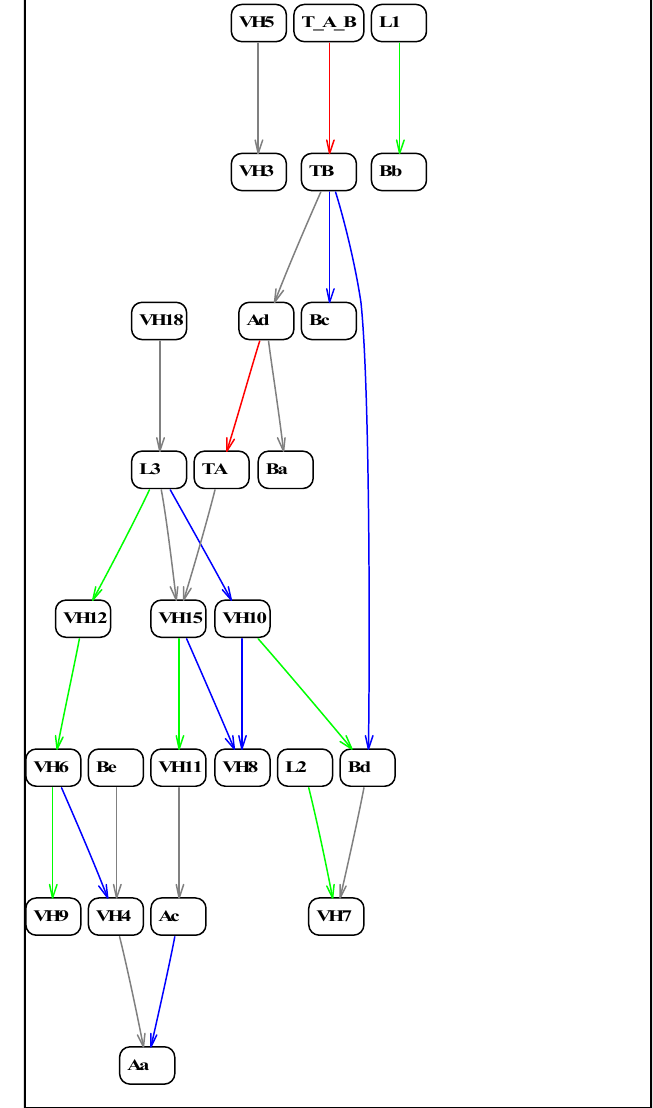
Figure 9. Implicative graph for all didactic variables (level of geometrical thinking of the students, student´s solution to the van Hiele test, student´s solution to Task A, student´s solution to Task B).